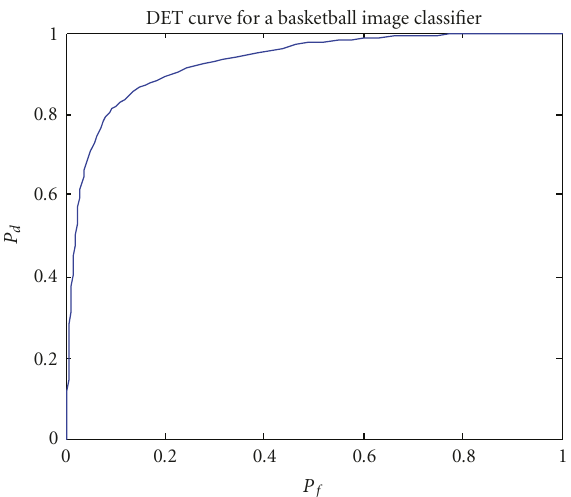
Figure 3: The DET curve for an image classifier used to detect basketball images